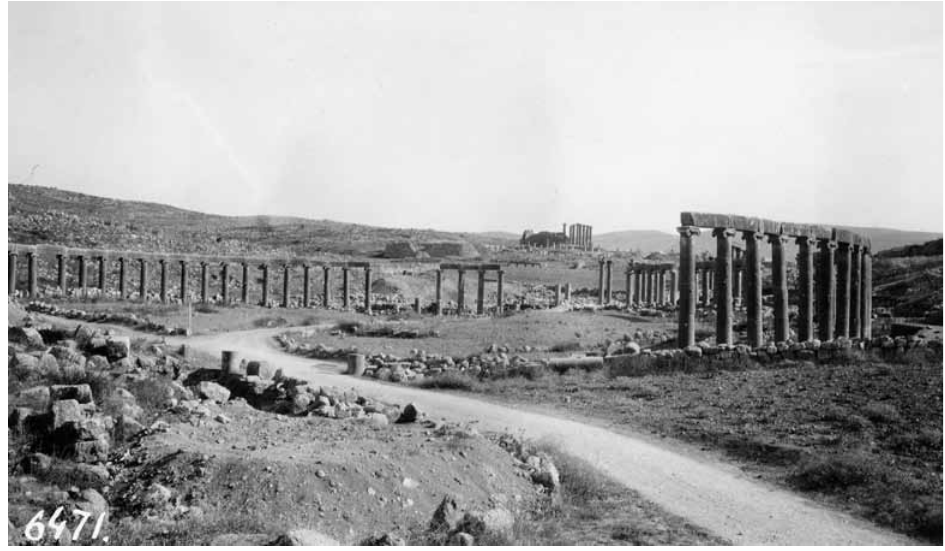
Fig. 1: History of Archaeology Research Group. The forum and temple of Artemis at Jerash, an image from the Horsfield